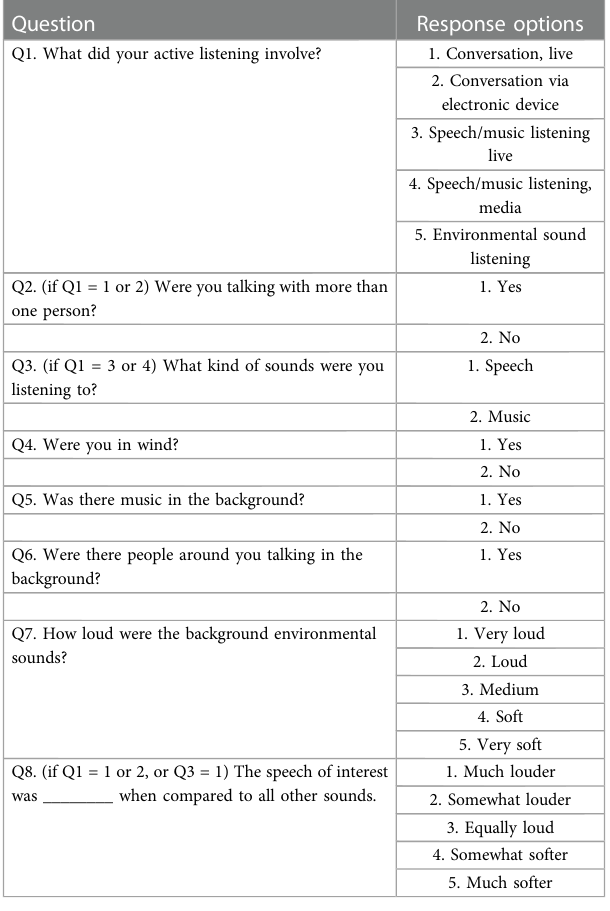
Question Response